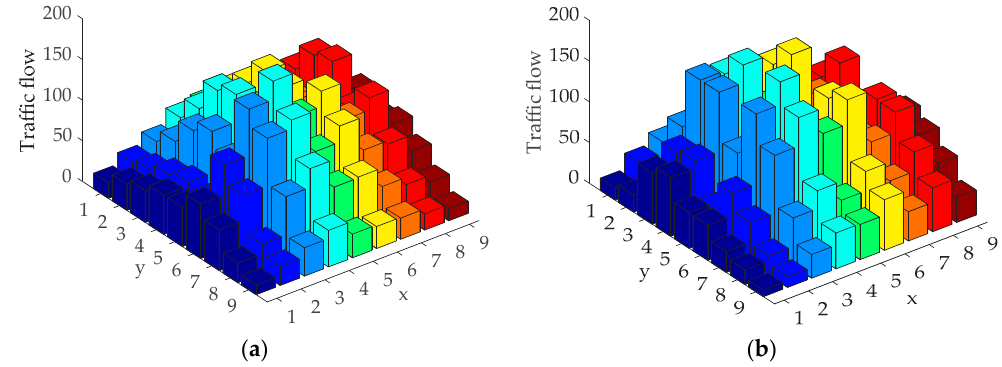
Figure 19. The traffic flow of each traffic node before and after the planning of the fast charging stations; ( a ) the traffic flow before the planning of the fast charging stations; ( b ) the traffic flow after the planning of the fast charging stations